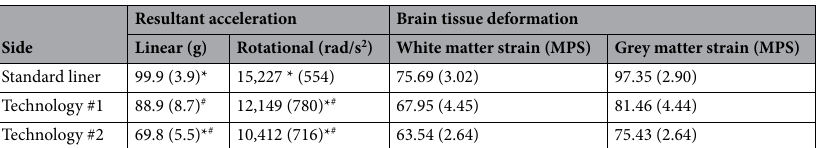
Table 2. Summary table with means of impact variables measured along with the standard deviations in brackets for the side location. *Indicates significant difference (alpha level p < 0.05), when the two technologies are compared to the standard liner. # Indicates significant difference (alpha level p < 0.05), when the two technologies are compared to each other.